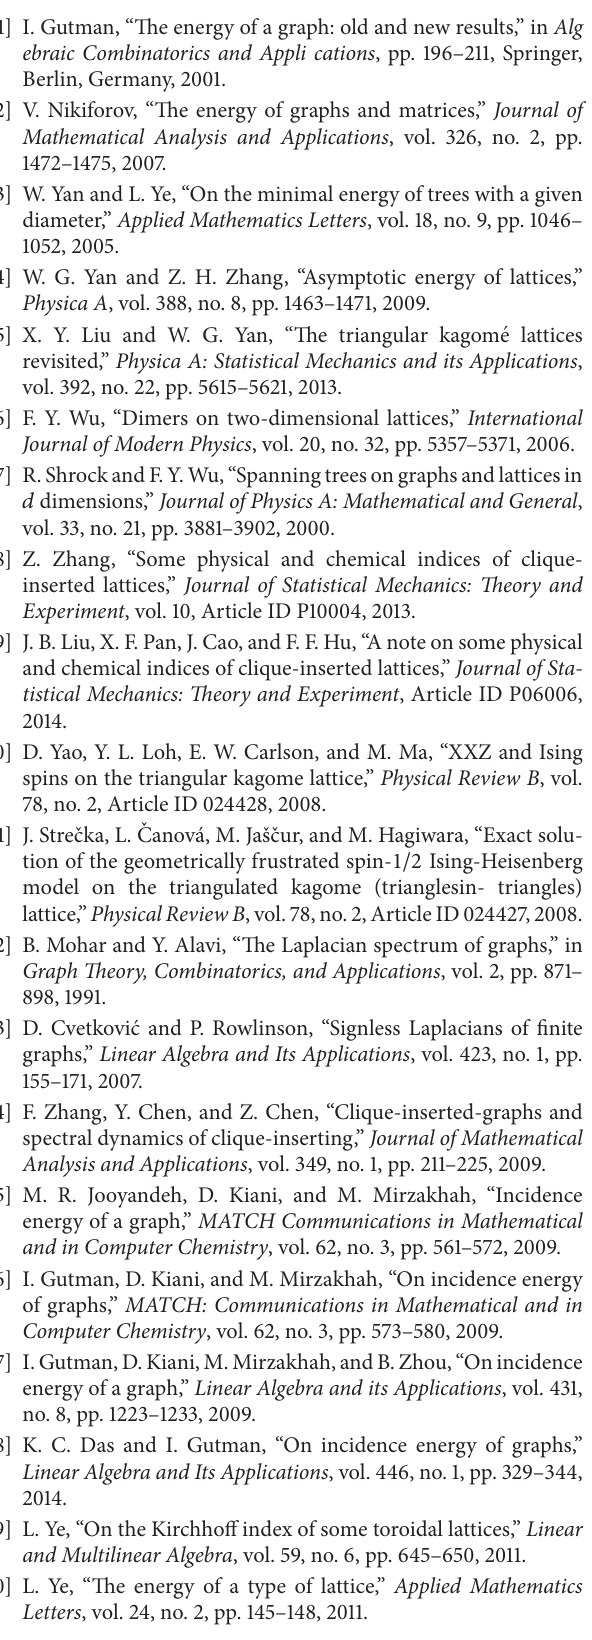
Figure3:The 𝑆 𝑡 (𝑚,𝑛) latticewithtoroidalboundarycondition[20].